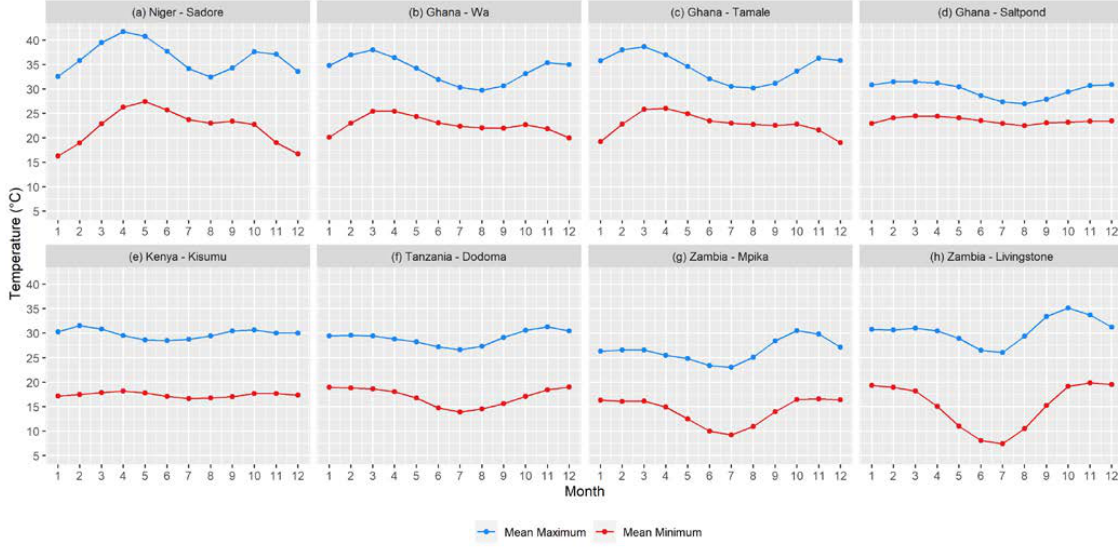
Figure 2. Annual cycle of monthly mean maximum (blue) and minimum (red) temperature from the stations in Niger and Ghana ( a – d ) and Kenya, Tanzania and Zambia ( e – h ).